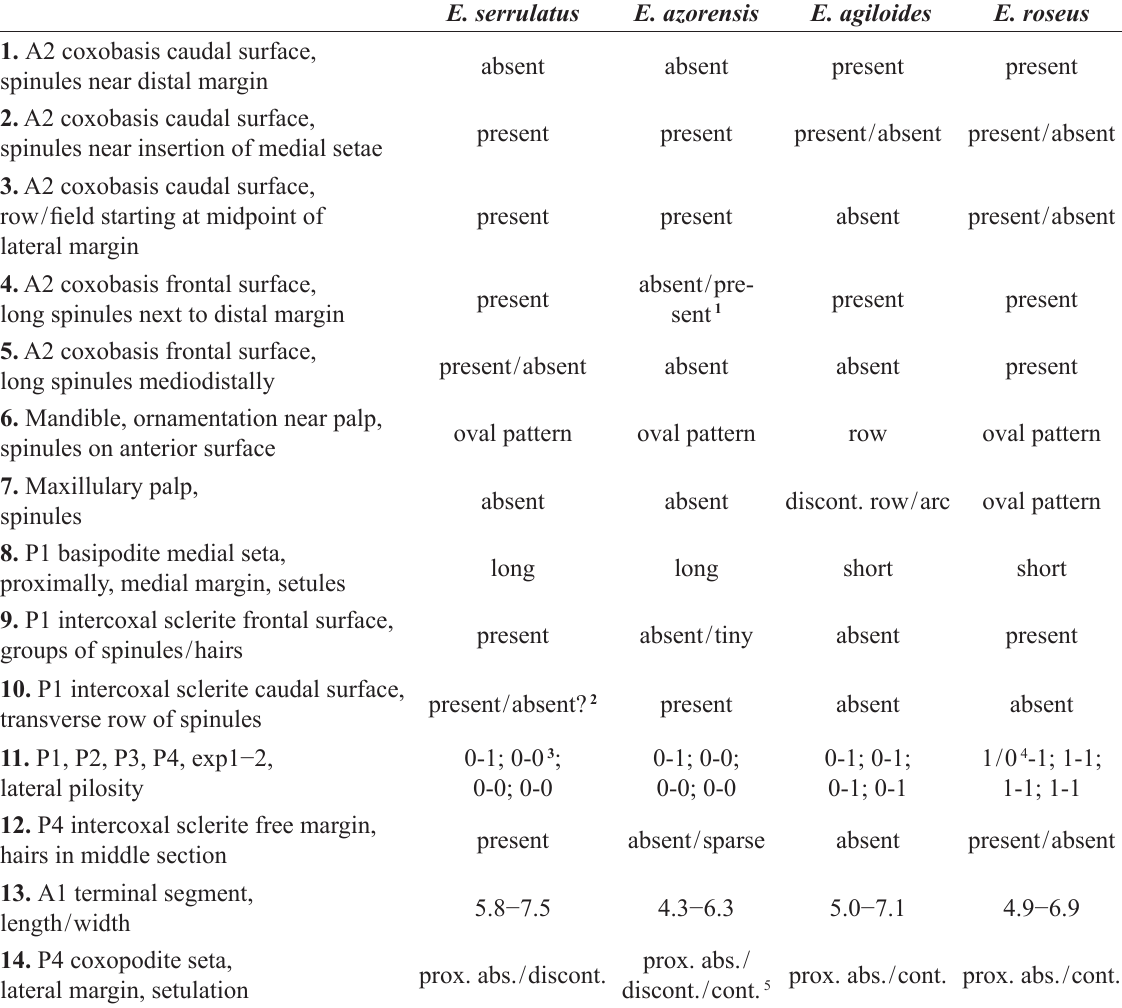
Table 5. Comparison of the diagnostic morphological characters in the female of Eucyclops azorensis Defaye & Dussart, 1991 and the putative close relatives. Character states were verified in all dissected specimens listed in ʻMaterial examinedʼ and ʻComparative materialʼ (see the species